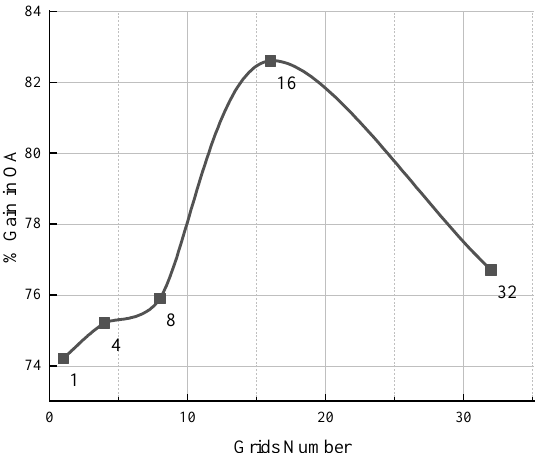
Figure 5. Evaluation results of the pretrained model using different numbers of grids (i.e., ScanOb-